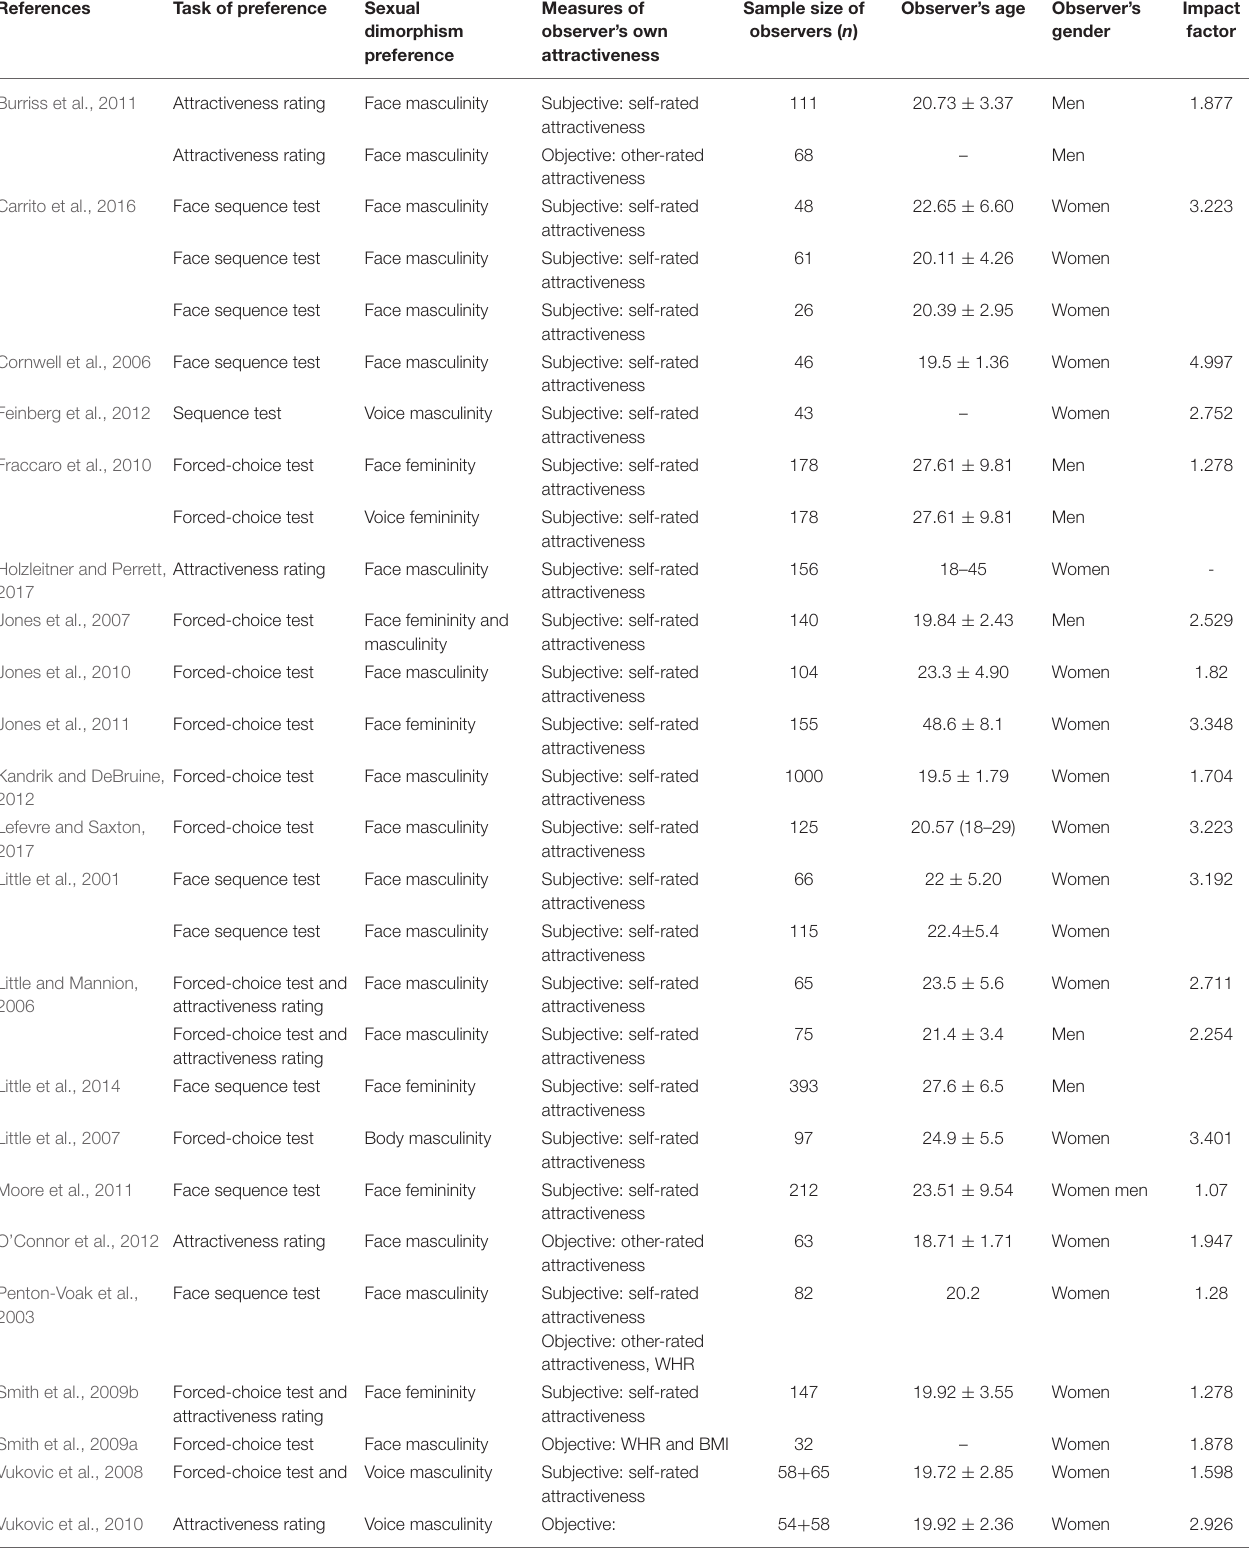
TABLE 1 | Characteristics of the 25 studies included in the present